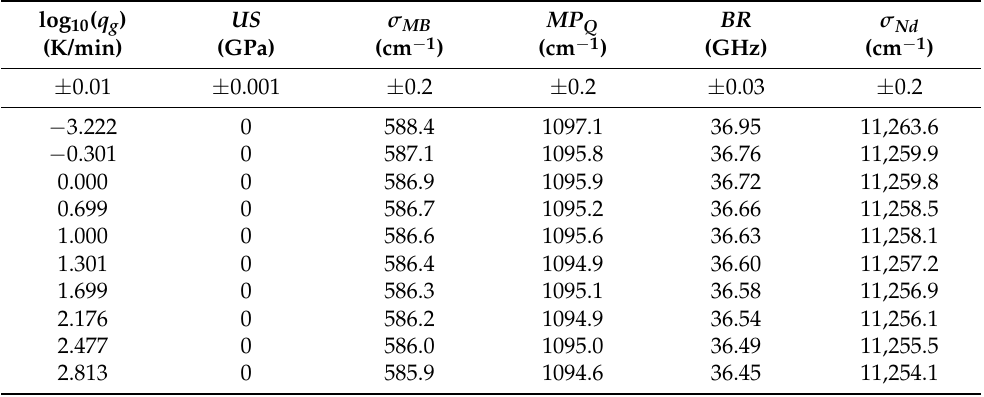
Table A1. Experimental data and spectroscopic observables of the q g 1 sample used for the multiple linear regression model.